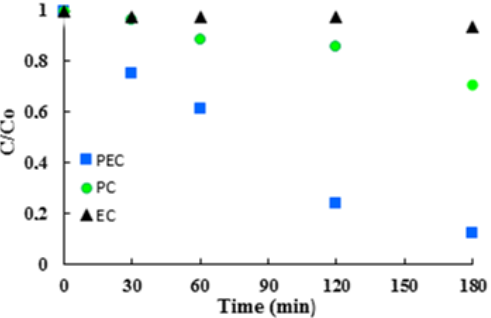
Figure 13. Experimental results of PC, EC and PEC degradation of paraquat by using Ti/TiO 2 NTEG- 6h-500 photoanode. [paraquat]: 37.4 µ M, applied potential vs. Ag/AgCl: 1.0 V.